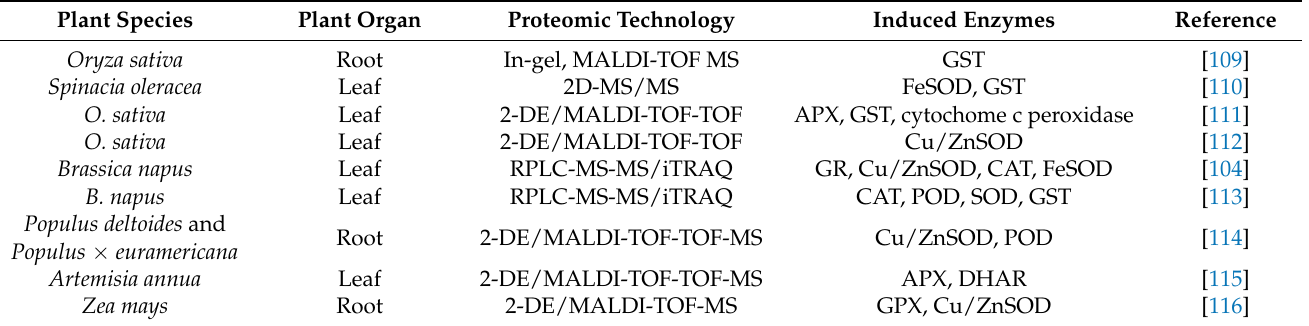
Table 2. Some examples of proteomic studies involving the quantification of antioxidant enzymes in As-exposed